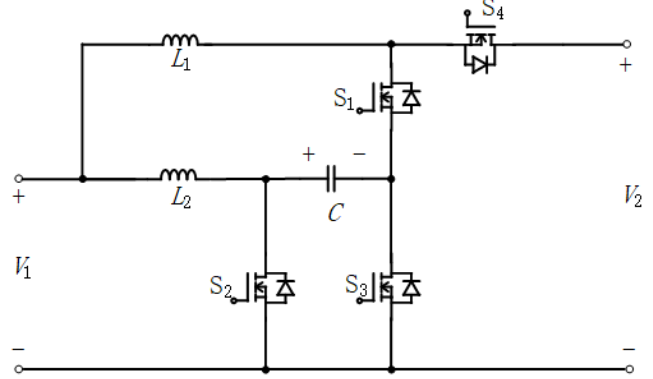
Figure 6. A non-isolated bidirectional DC-DC converter in [15].